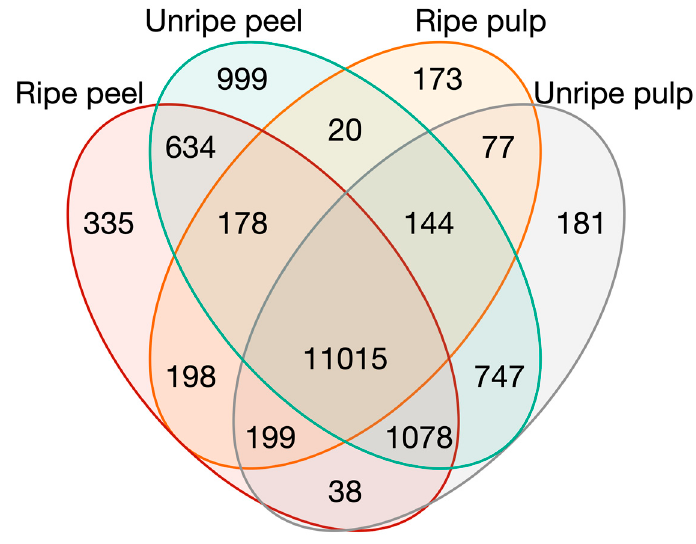
Figure 4. Venn diagram of genes expressed in ripe and unripe pulp and peel.